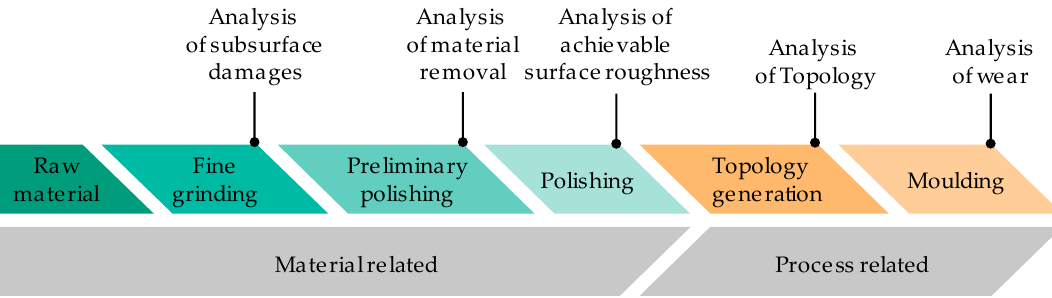
Figure 2. Approach used for studying the wear behaviour of Glassy Carbon forming tools in Fused Silica PGM.